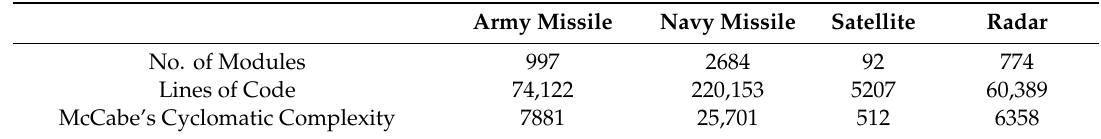
Table 4. Software information of the case